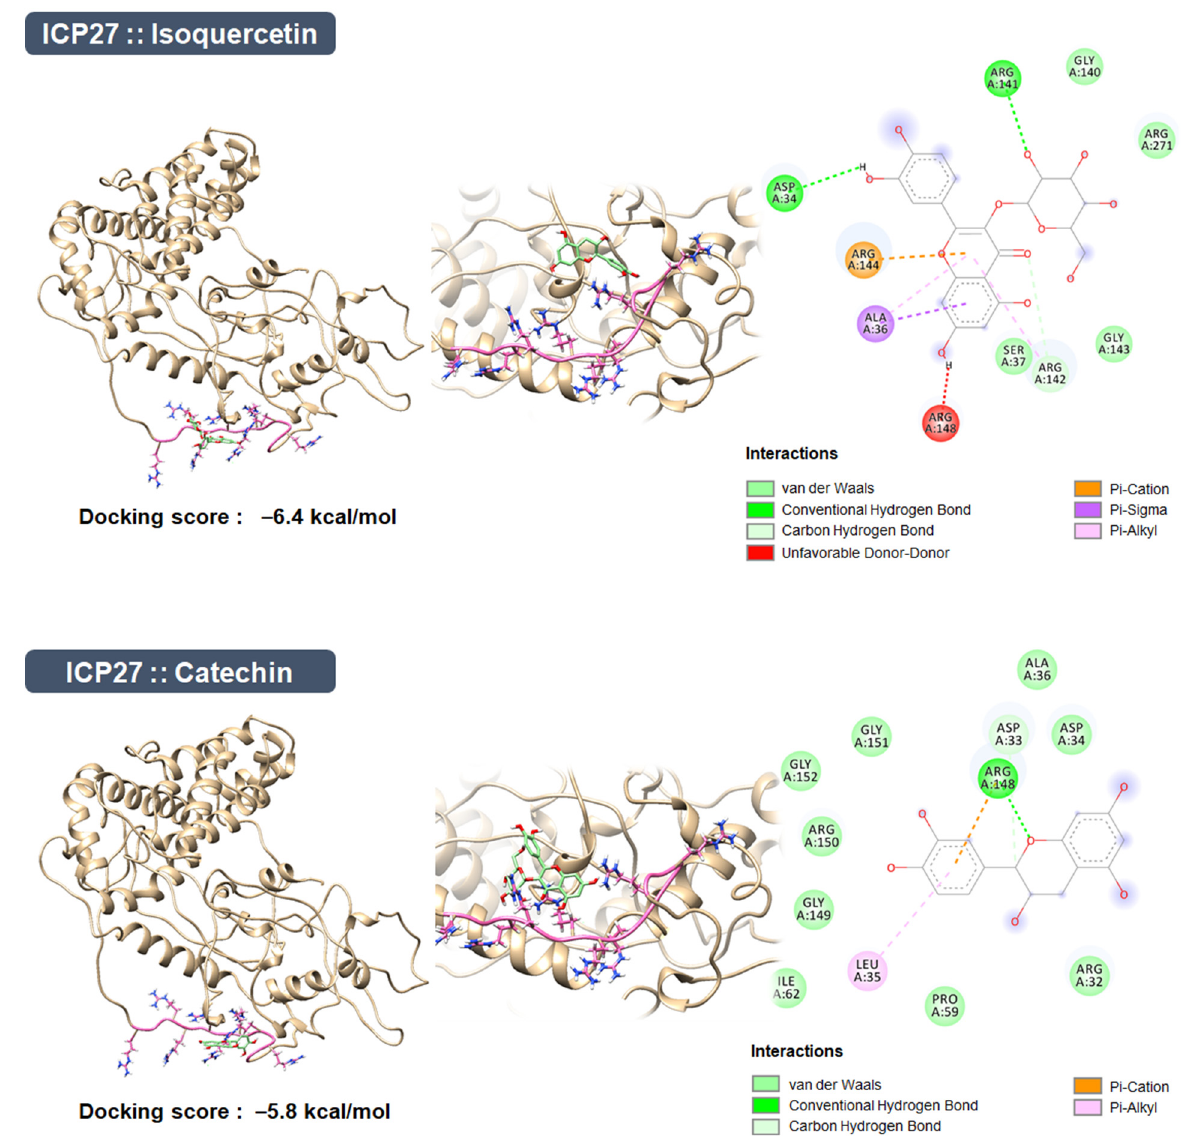
Figure 9. Molecular docking simulation and pharmacophore analysis between model HSV-1 ICP27 and isoquercitrin/catechin. Using AutoDock Vina integrated with UCSF Chimera v1.15, both ligands, isoquercitrin and catechin, were docked onto the model ICP27 structure built by the deep learning-based Robetta server and included the RGG box (Arg138-Gly152). The binding affinities between the receptor and each ligand are indicated as the lowest energy score in the molecular docking simulation, and their interactions were analyzed using BIOVIA Discovery Studio Visualizer.